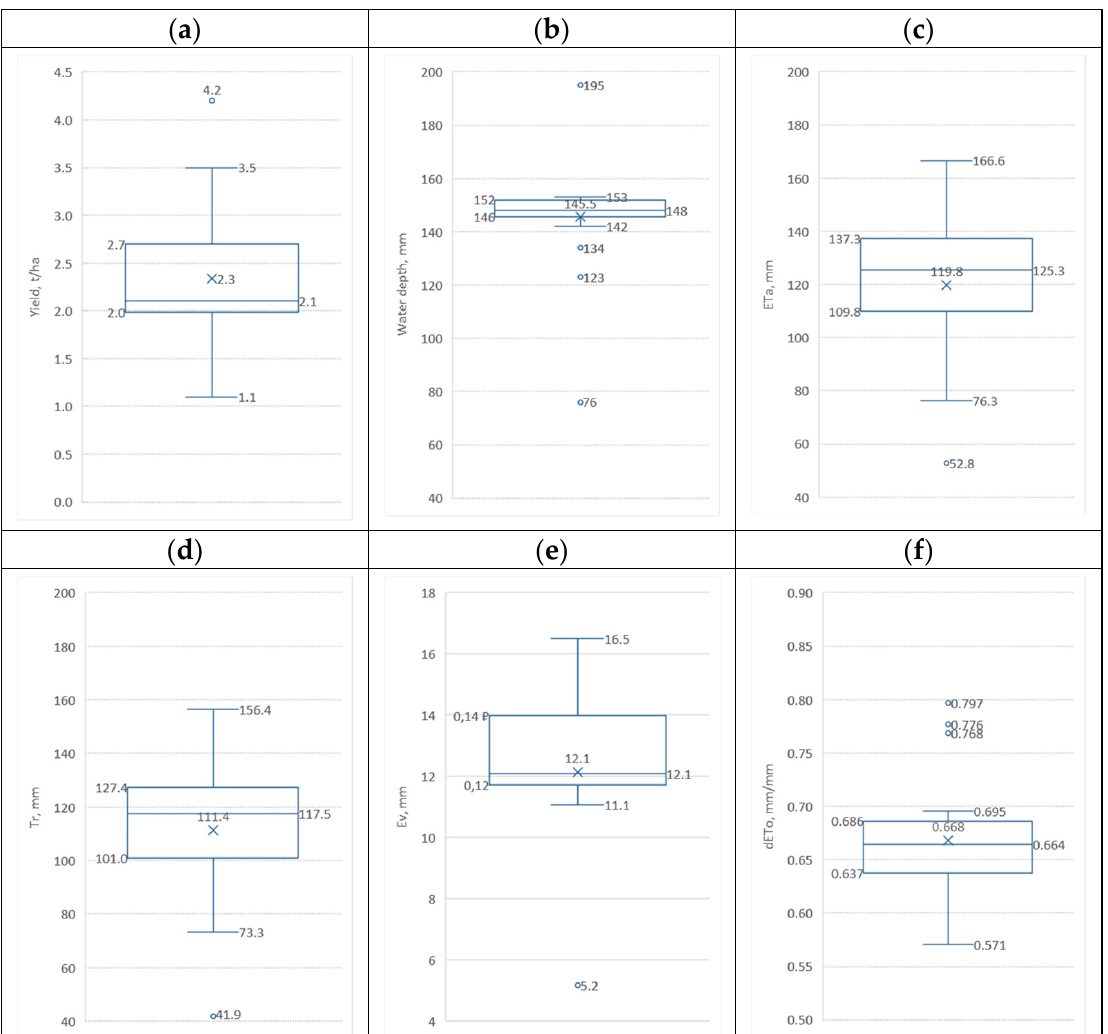
Figure 4. Box and wishers plots showing the lower quartile (Q1), the median (Q2), the upper quartile (Q3), the mean (×), and the minimum and maximum values ( ◦ outlier values are also depicted) for studied irrigated alfalfa crops during 05.05.2012–10.08.2012 period for: ( a ) yield of organic carbon; ( b ) irrigation depths; ( c ) evapotranspiration; ( d ) plant transpiration; ( e ) evaporation from soil cover; ( f ) average deficit of basal evapotranspiration.